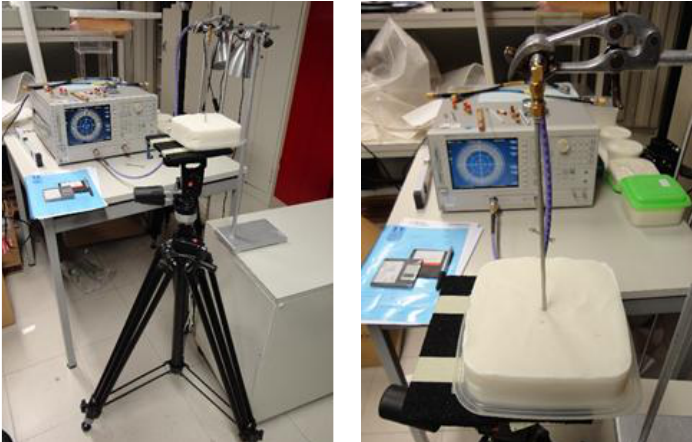
Figure 10. Photographs of the measurement setup used to measure the phantom samples using the sample left open as an example.